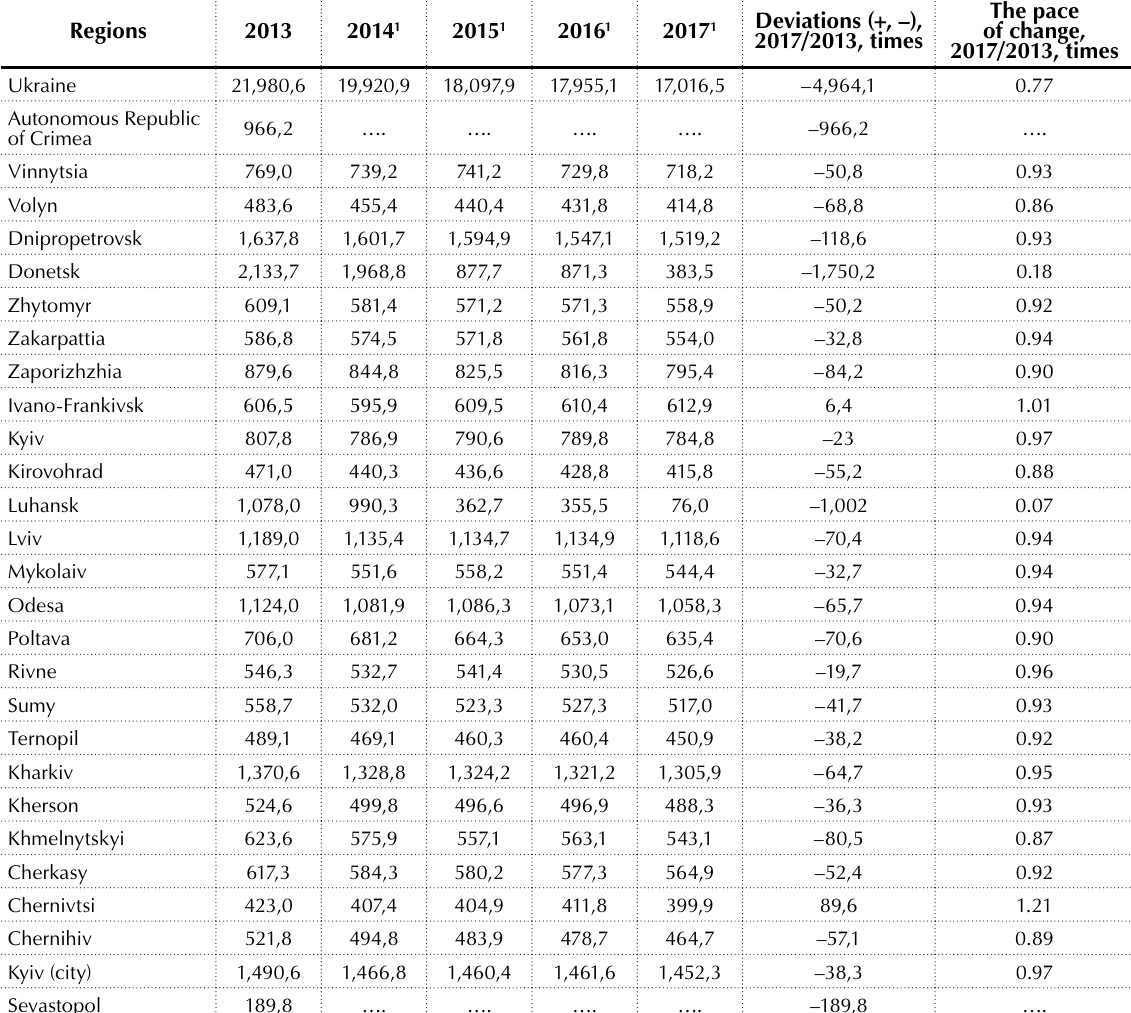
Source: Statistical collection “Regions of Ukraine” for 2017; Державна служба статистики України